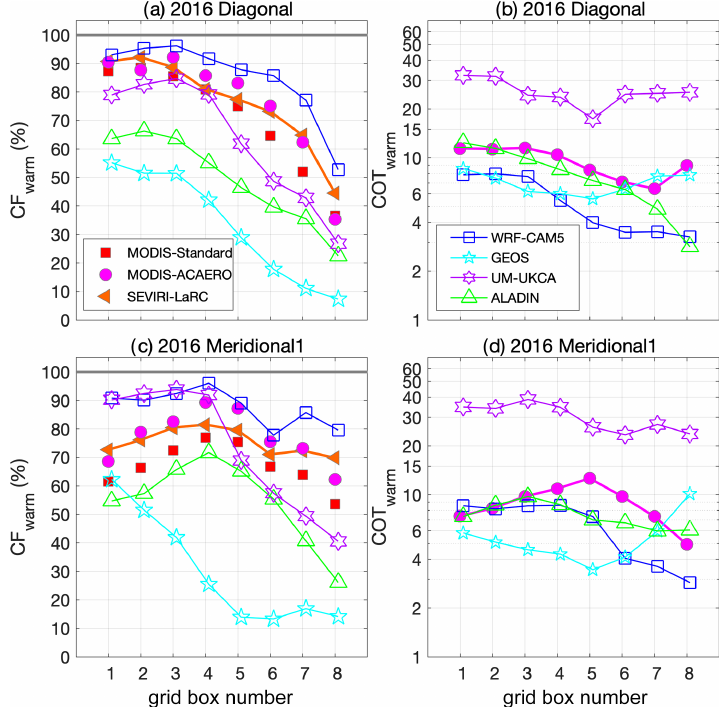
Figure 23. Average daytime mean CF warm (a, c) and COT warm (b, d) from satellite retrievals and from the models for the comparison grid boxes in the 2016 diagonal (a, b) and meridional 1 (c, d) transect. COT warm is the geometric mean, except for the ALADIN model, which shows the median. The SEVIRI-LaRC dataset is used as the reference for observed CF warm , and the MODIS-ACAERO dataset is used as the reference for observed COT warm in the comparison to